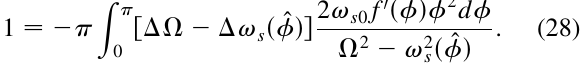
(cid:7) 60 (cid:12) . m